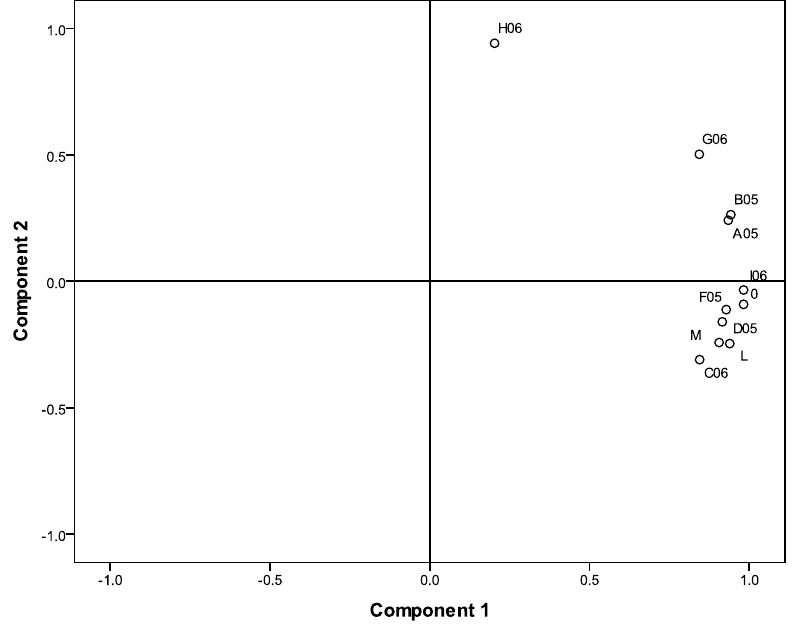
Figure 3. The honey samples separated by Principal Component Analysis (PCA) on the basis of physicochemical variables, phenolic content and radical scavenging